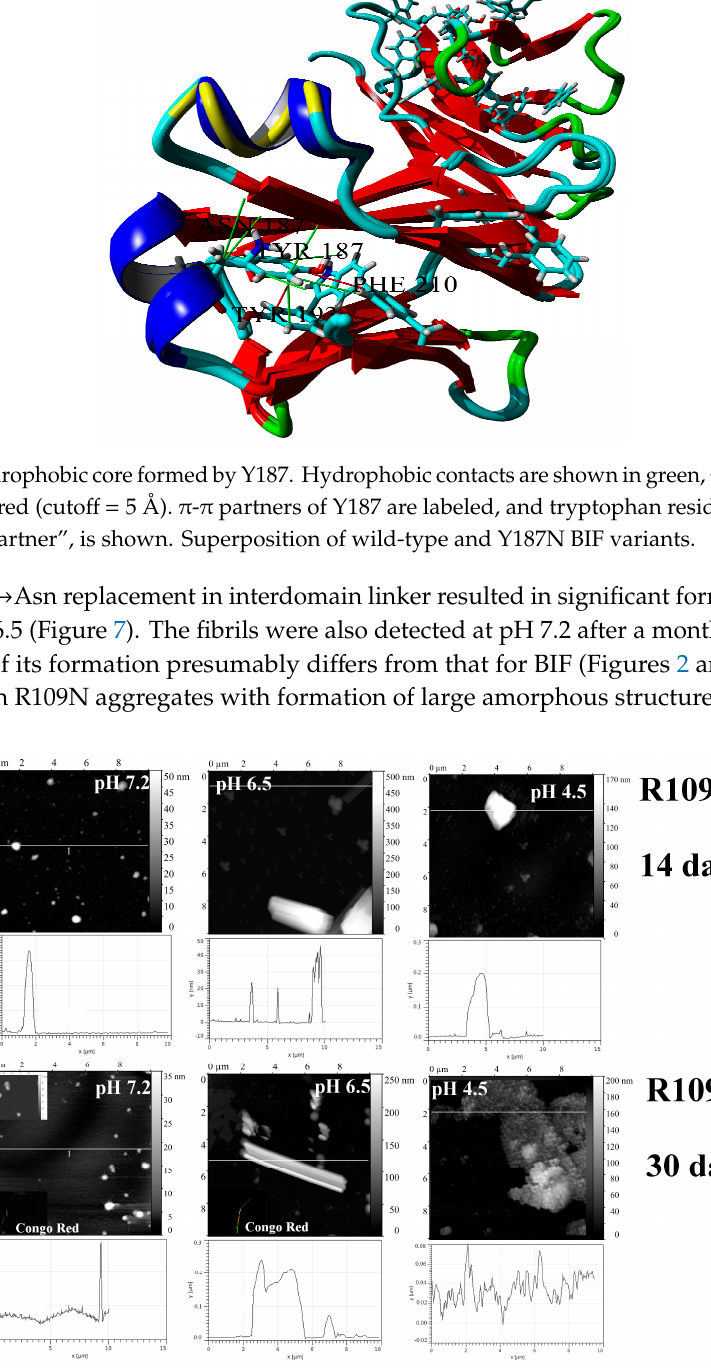
Figure 7. The morphology of R109N aggregates at pH 7.2, 6.5 and 4.5 after 14 days and 30 days of incubation at 37 ◦ C (AFM images obtained in tapping mode). Congo Red birefringence is